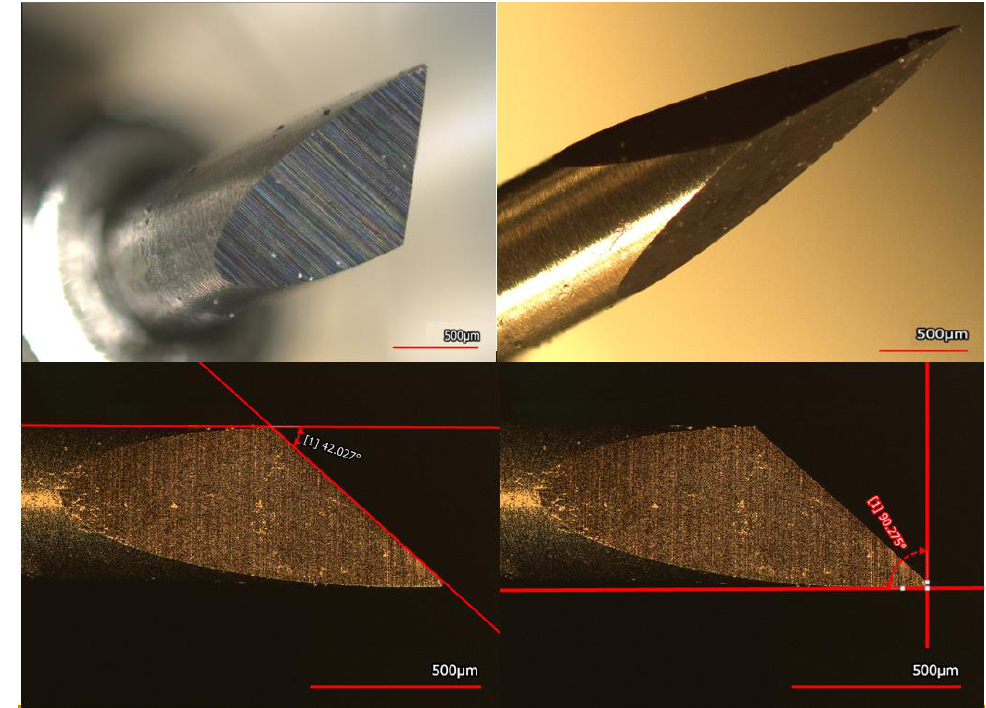
Figure 2. Laser confocal scanning images of the AutoBlade from the plotter cutter showcasing ellipsoidal curvature on the left and tip dimensions on the right. The blade characterization helps with assessment of cutting features on specific materials.